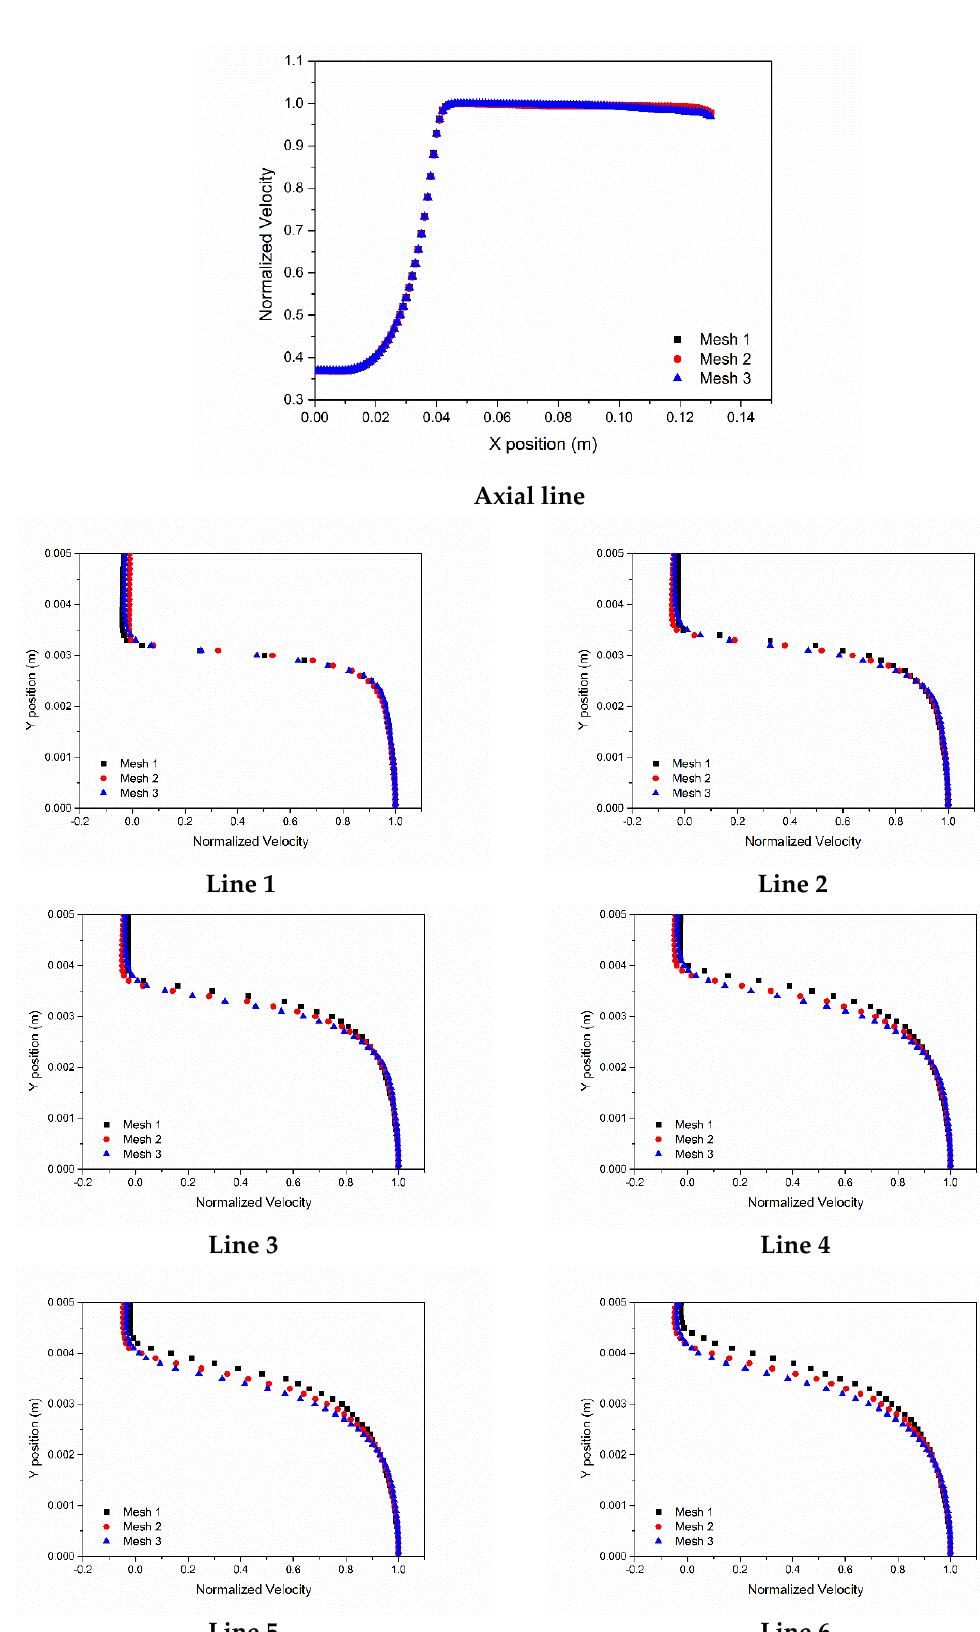
Figure 9. The distribution of monitor lines.